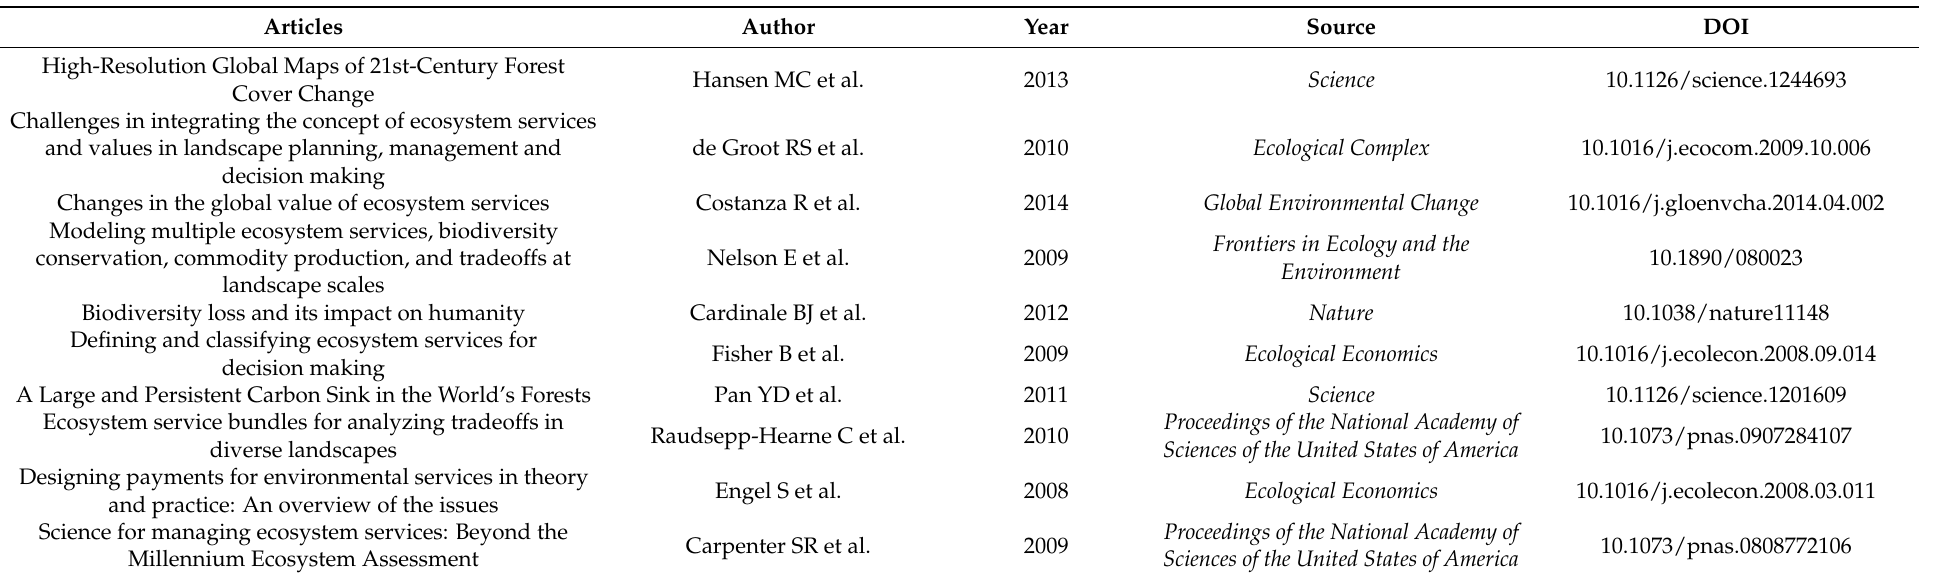
Table 4. Top 10 most cited articles in terms of the number of publications on FES-related